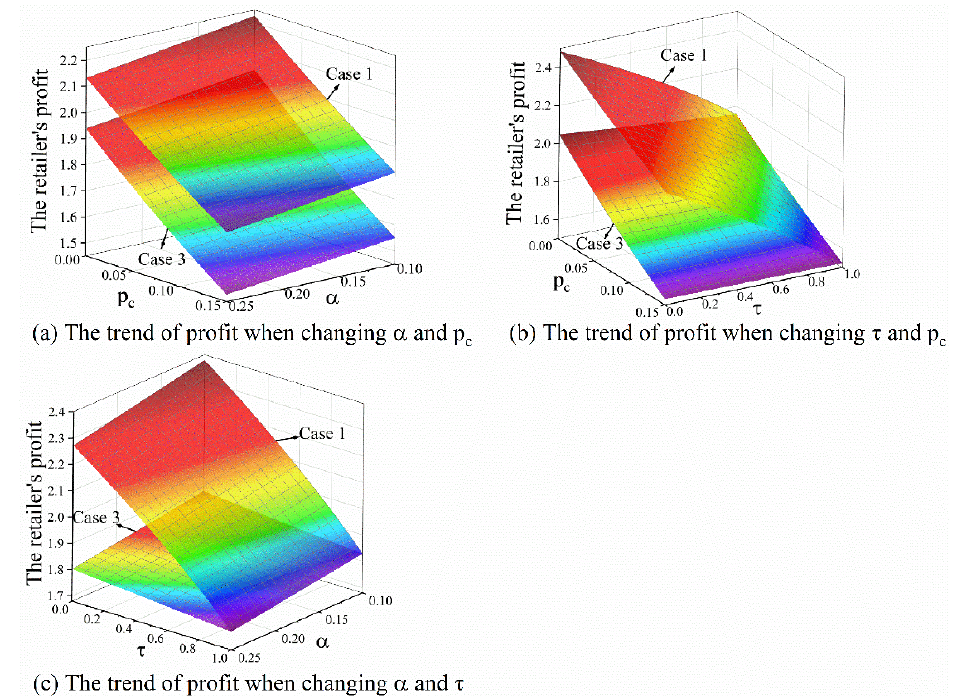
Figure 12. The retailer’s profits under different levels of α , τ , and p c .